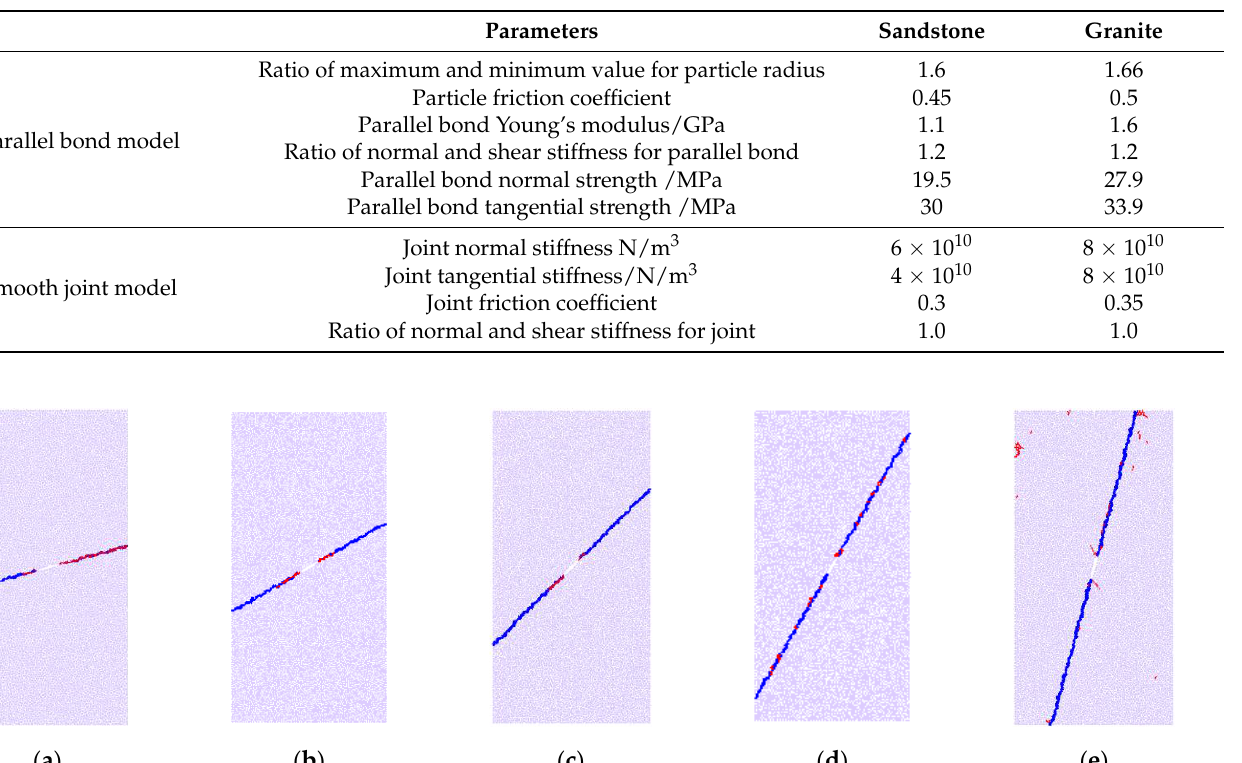
Table 4. Microscopic parameters of numerical models.